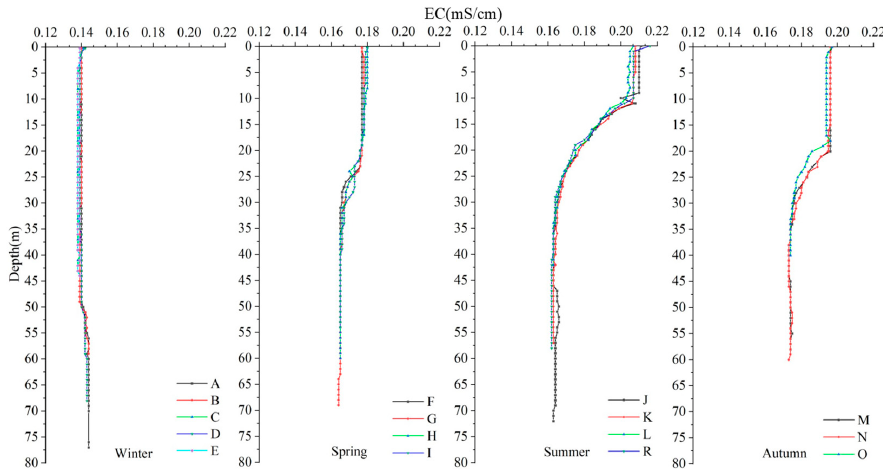
Figure 3. Seasonal variations of vertical electrical conductivity (EC) in Lake Lugu.